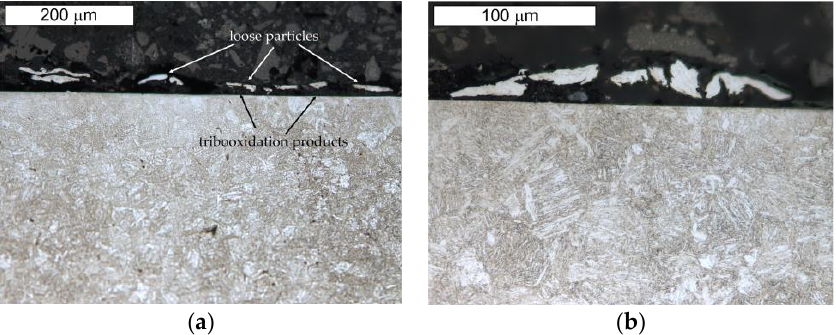
Figure 15. View of ( a ) the microstructure of steel Hardox in the surface area and ( b ) a magnified fragment of the area in Figure 15a. Light microscopy, etched.